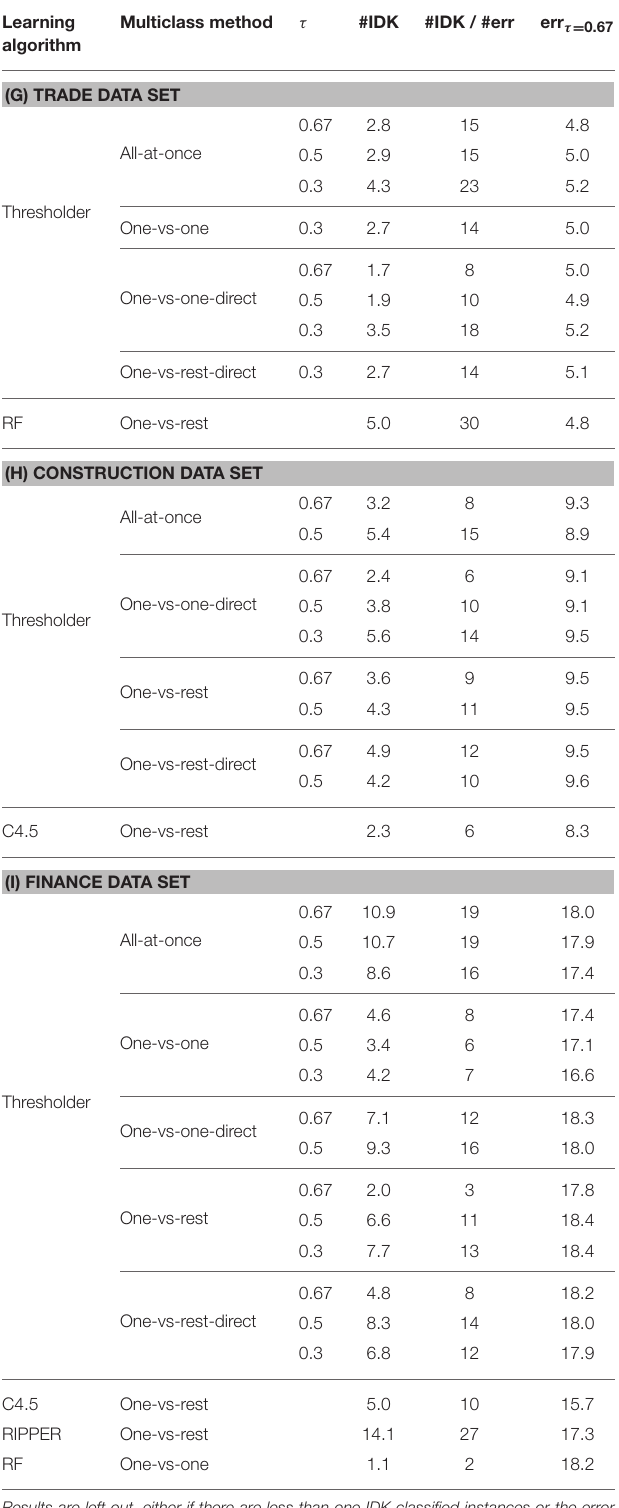
TABLE 7 | Absolute number of IDK-assignments and error rate and number of IDK-assignments per misclassifications in percent of all learning algorithms and IDK-classifier capable multiclass